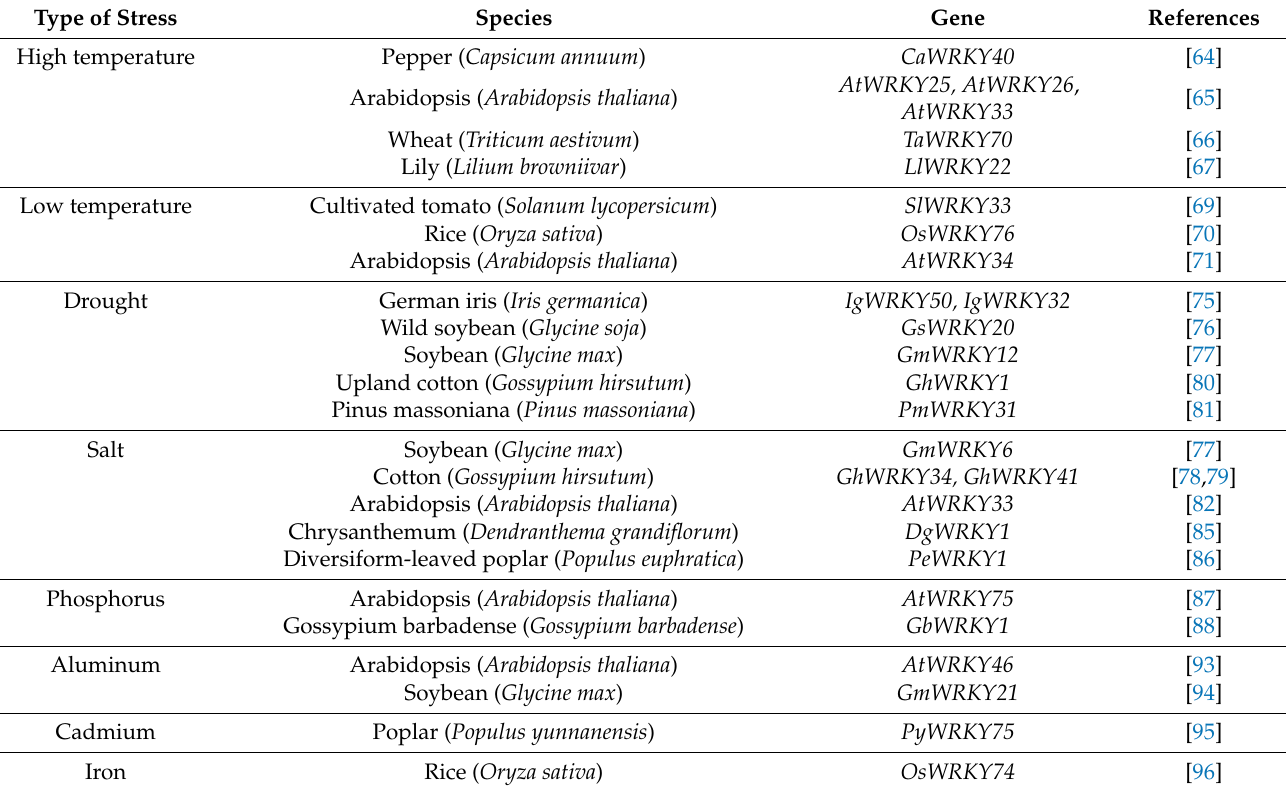
Table 2. Regulation of WRKY transcription factors in abiotic stress responses.